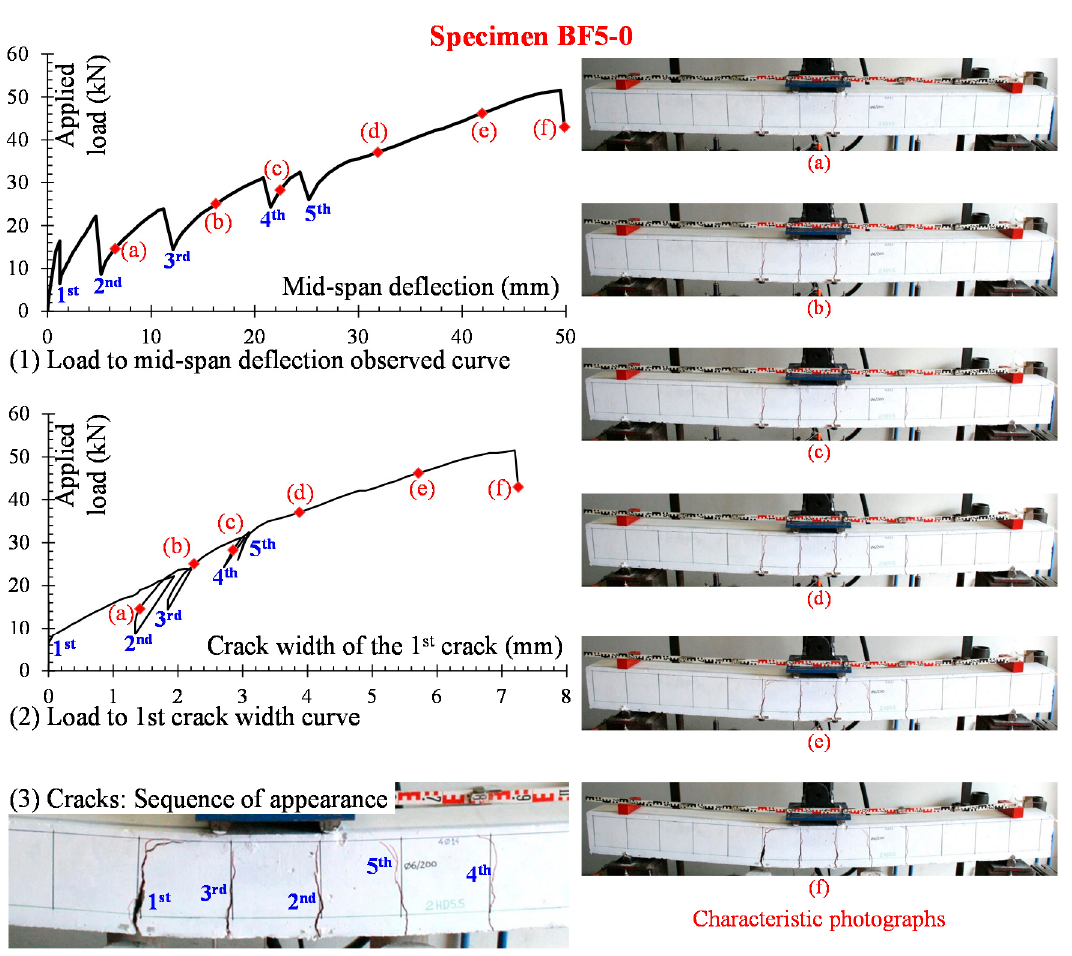
Figure 4. Beam BF5-0. Load to midspan deflection (1) and load to crack width (2) observed curves. Photographs at characteristic points ( a ) to ( f ). Sequence of appearance of the observed cracks (3).